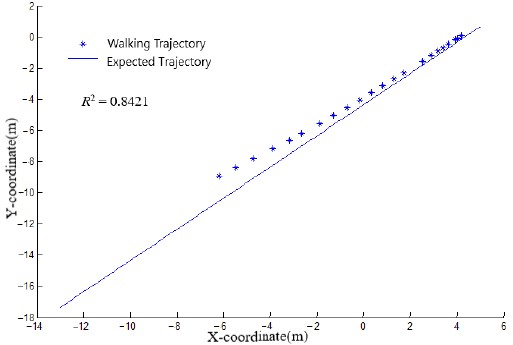
Figure 18. X-Y coordinates of non-controlled strategy.